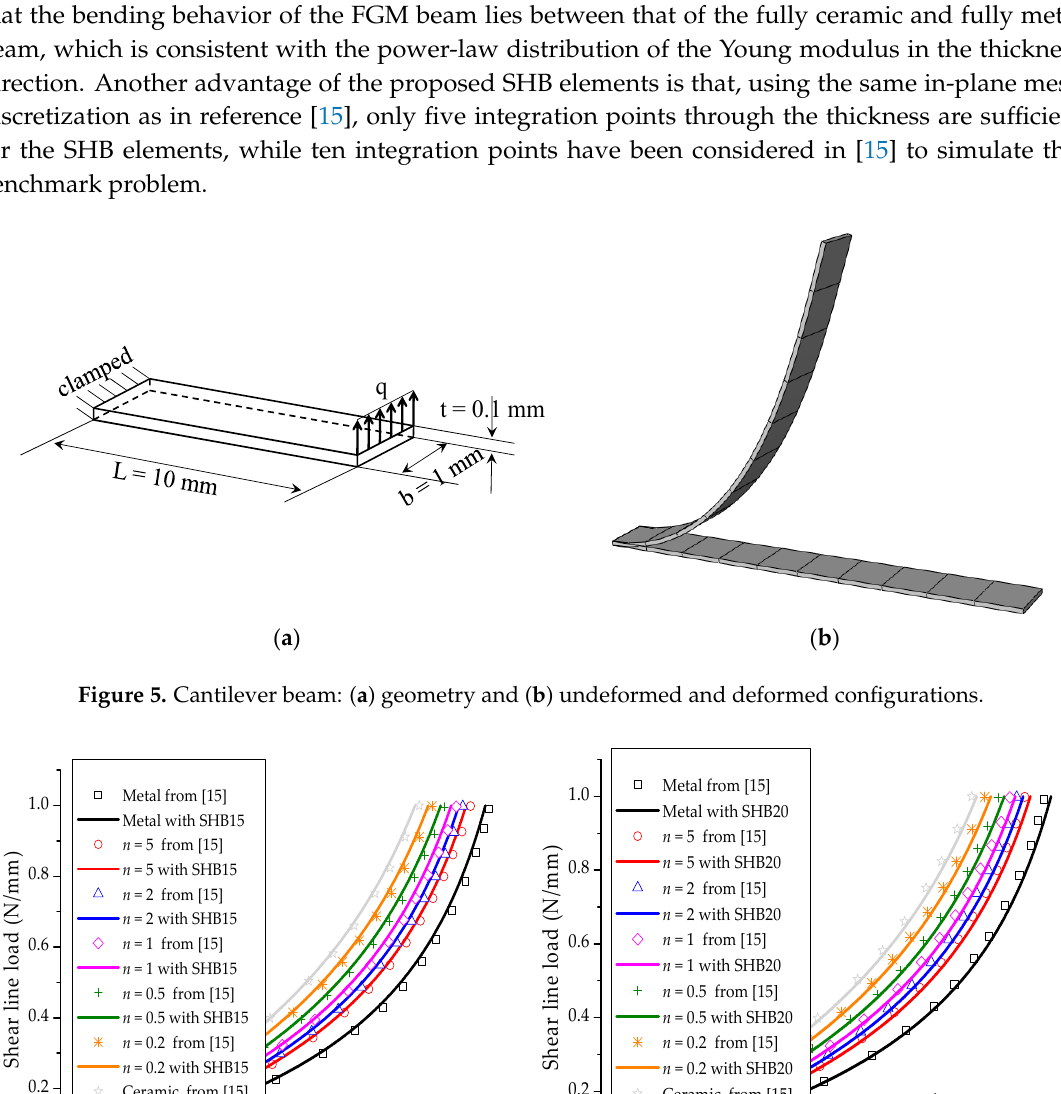
( b ) Figure 7. Slit annular plate: ( a ) geometry and ( b ) undeformed and deformed configurations.